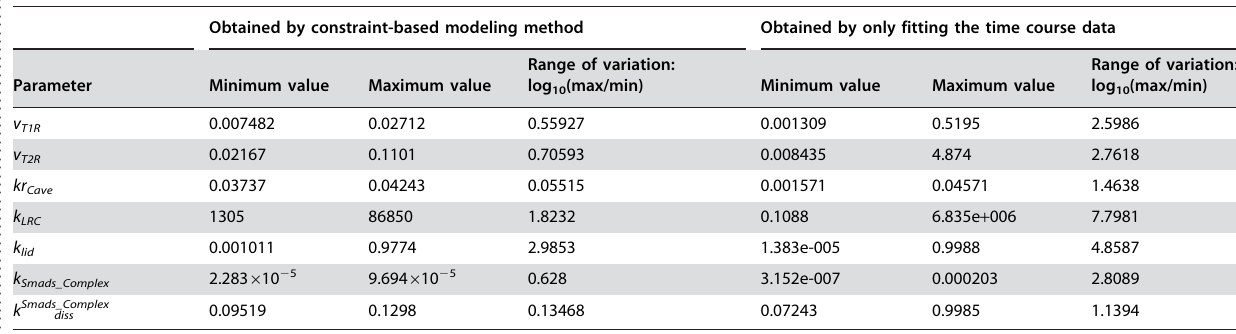
Table 3. Range of the variation for the estimated parameters in the 1000 parameter sets .. ... .... ... ... .... ... ... .... ... ... .... ... ... .... ... ... .... ... ... .... ... ... .... ... ... .... ... ... .... ... ... .... ... ... .... ... ... .... ... ... .... ... ... . Obtained by constraint-based modeling method Obtained by only fitting the time course data Parameter